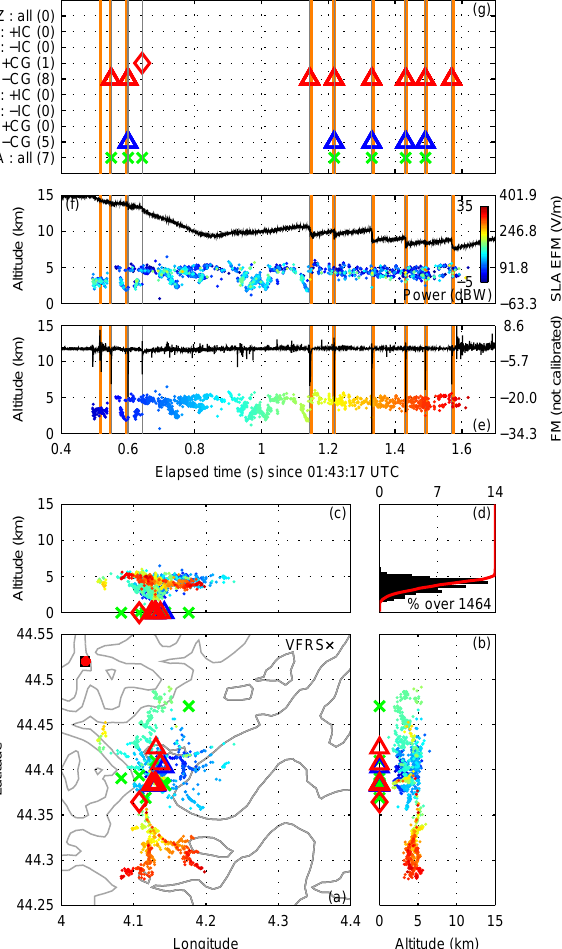
Figure 4. Records during a − CG flash with multiple ground con- nections (24 September 2012, 01:43:17UTC) with (a) ground pro- jection of the lightning records; (b) latitude–altitude projection of the lightning records; (c) longitude–altitude projection of the light- ning records; (d) histogram (bars) and cumulative distribution (red cure) of the VHF source altitude; (e) time–height series of VHF sources and record of the Uzès SLA; (f) amplitude–height series of VHF sources and record of the VFRS electric field observations; and (g) records of OLLSs per instrument and type of detected events available only for EUCLID and LINET. The orange bars correspond to ground strokes as identified from VFRS records. The VFRS lo- cation is also indicated in (a) . Gray lines indicate times of all OLLS reports. Records from ATDnet, EUCLID, LINET and ZEUS are plotted with green crosses, blue symbols, red symbols and black stars,